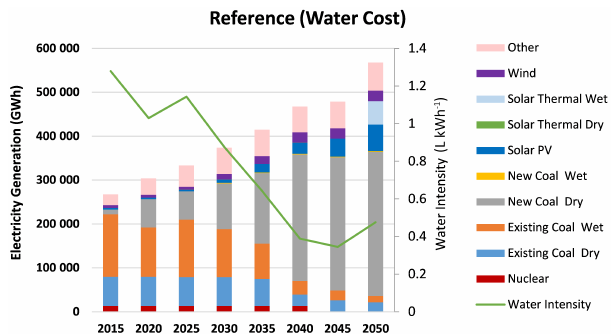
Figure 4. Optimal future energy mix under the reference scenario but with regional variability in water supply costs.